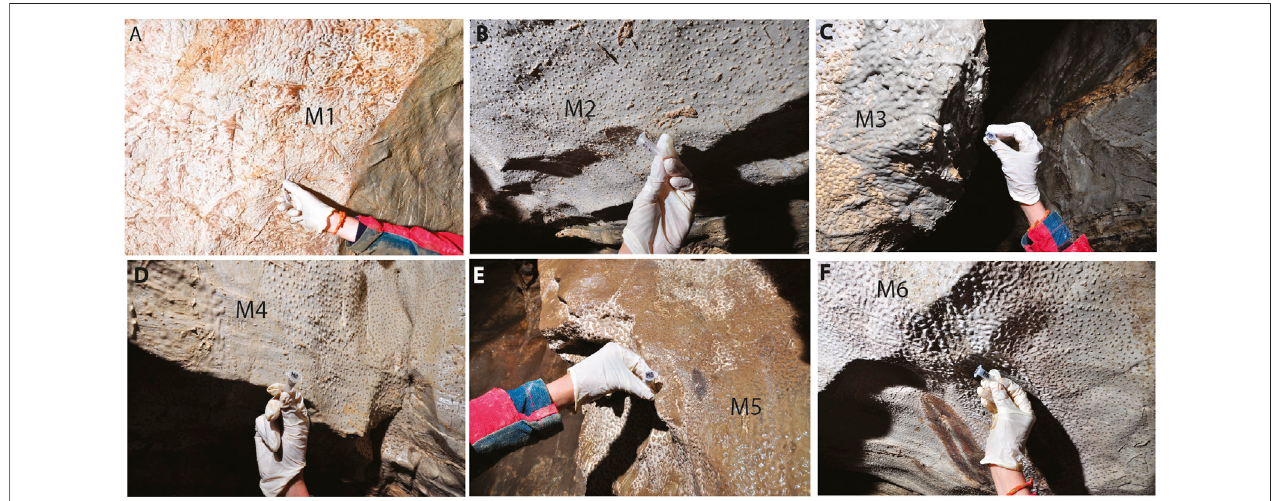
FIGURE 2 | (A-F) Vermiculation deposits (from M1 to M6) collected from the walls of Morgana Cave. They present different shapes and colors such as whitish, brown, and greyish (photos by M. Inglese).